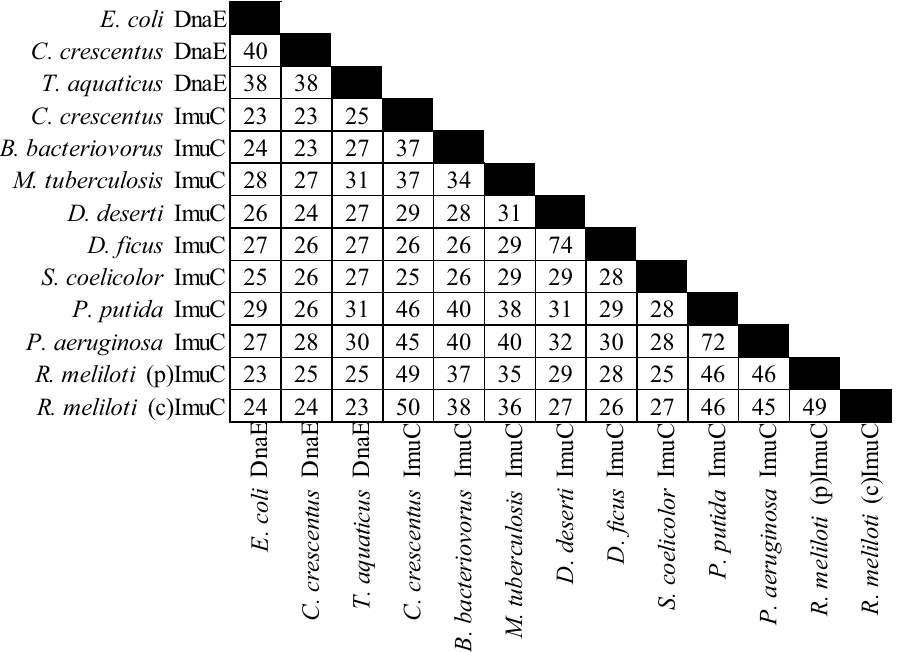
Figure 4. Percent identities by ClustalW2 [213,214] for ImuC proteins and related (cid:83)(cid:85)(cid:82)(cid:87)(cid:72)(cid:76)(cid:81)(cid:86)(cid:17)(cid:3)(cid:179)(cid:11)(cid:83)(cid:12)(cid:180)(cid:3)(cid:85)(cid:72)(cid:83)(cid:85)(cid:72)(cid:86)(cid:72)(cid:81)(cid:87)(cid:86)(cid:3)(cid:87)(cid:75)(cid:72)(cid:3)(cid:83)(cid:79)(cid:68)(cid:86)(cid:80)(cid:76)(cid:71)(cid:3)(cid:74)(cid:72)(cid:81)(cid:72)(cid:3)(cid:83)(cid:85)(cid:82)(cid:71)(cid:88)(cid:70)(cid:87)(cid:15)(cid:3)(cid:179)(cid:11)(cid:70)(cid:12)(cid:180)(cid:3)(cid:85)(cid:72)(cid:83)(cid:85)(cid:72)(cid:86)(cid:72)(cid:81)(cid:87)(cid:86)(cid:3)(cid:87)(cid:75)(cid:72)(cid:3)(cid:70)(cid:75)(cid:85)(cid:82)(cid:80)(cid:82)(cid:86)(cid:82)(cid:80)(cid:68)(cid:79)(cid:3)(cid:74)(cid:72)(cid:81)(cid:72)(cid:3) product. The accessions are from Uniprot [215] with the exception of D. ficus ImuC from RefSeq [216], from left to right: P10443, B8GWS6, Q9XDH5, B8H427, Q6MQS6, O50399, C1D2L1, ADO33730, Q9S291, Q88I82, Q9I5Q2, Q92ZJ6,